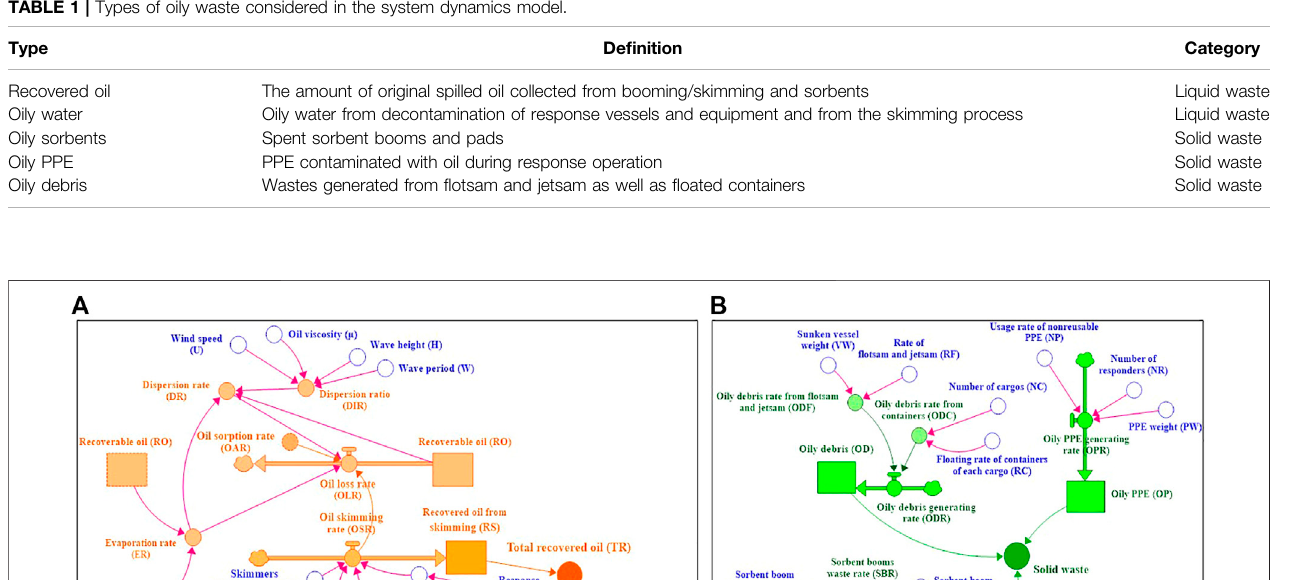
Frontiers in Environmental Science |